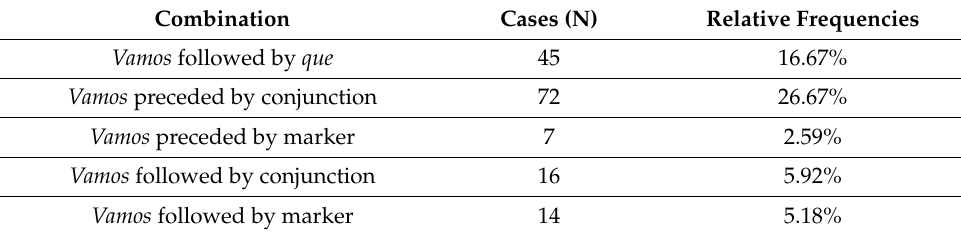
Table 7. Combination of the vamos marker with other connection units.